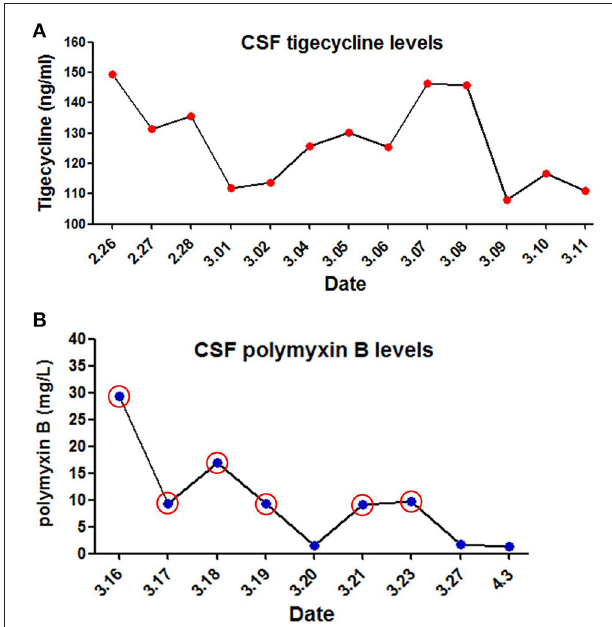
FIGURE 3 | Levels of tigecycline and polymyxin B in cerebrospinal fuid (CSF) of the patient. (A) CSF tigecycline concentrations were measured with Two-Dimensional High-Performance Liquid Chromatography (2D-HPLC) method. (B) CSF polymyxin B levels were determined using high performance liquid chromatography coupled with tandem mass spectrometry (LC-MS/MS). Red circle represents the day of ITH polymyxin B